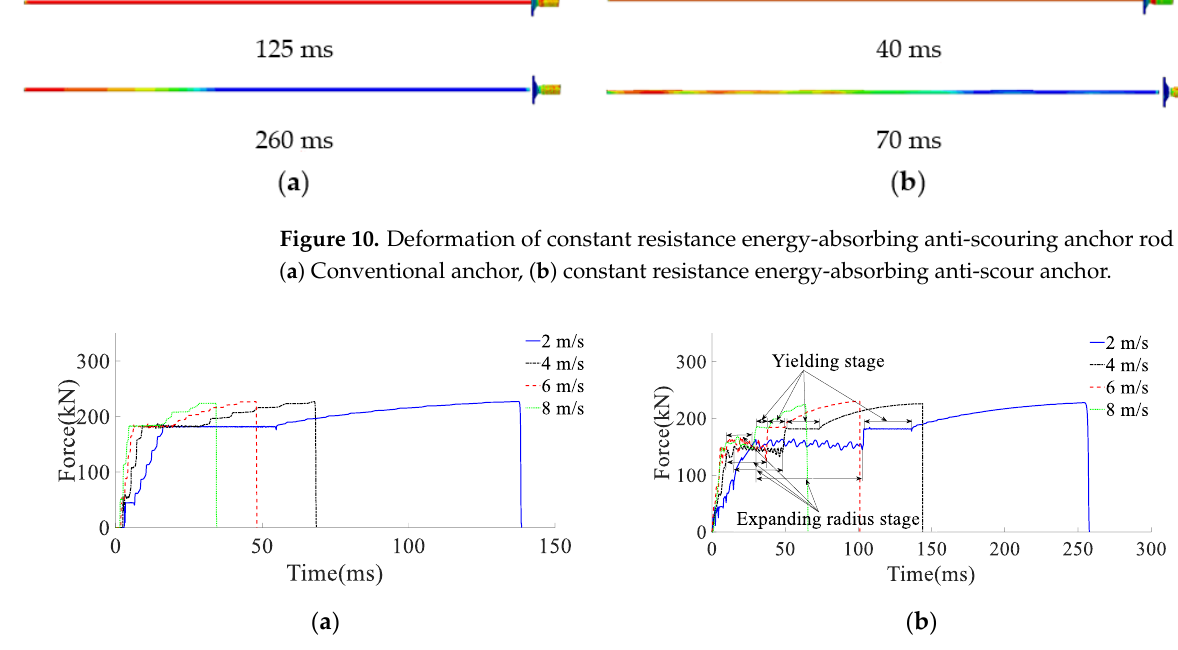
Figure 11. Anchor force – time curve. ( a ) Conventional anchor, ( b ) constant resistance energy-absorbing anti-scour anchor.